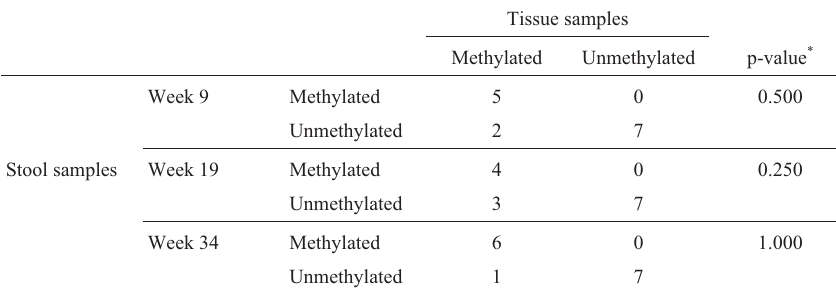
Table 2 - Consistency of p16 hypermethylation between tissue and stool samples.